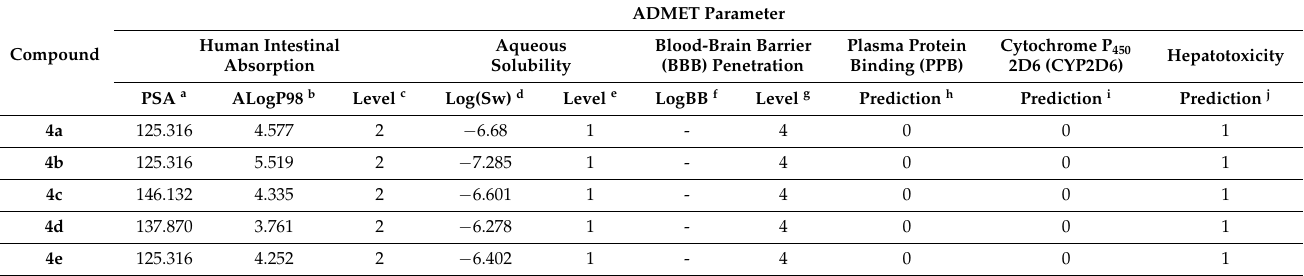
Table 3. ADMET profile prediction of compounds 4a – e .